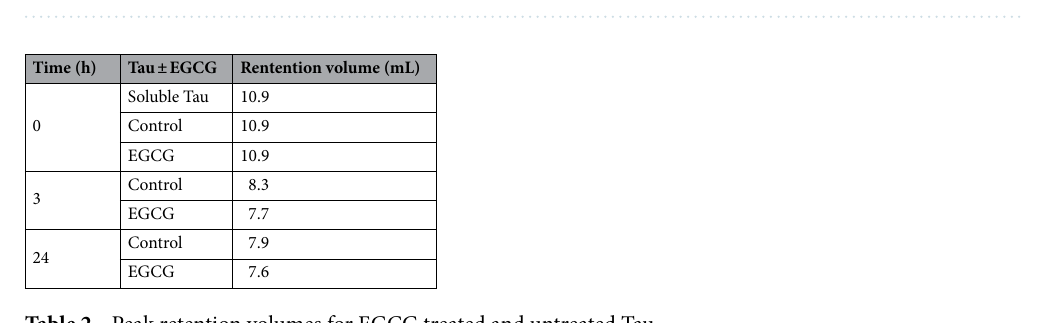
Figure 7. SEC for polyamines treated Tau. Tau was subjected to aggregation in presence of heparin as inducer. ( A ) At 0 h Tau was eluted as monomer, both in presence and absence of EGCG. ( B ) Further incubation led to aggregation of Tau, at 3 h of incubation EGCG showed more aggregation in Tau. ( C ) Similarly, at 24 the peak intensity of Tau in presence of EGCG was high when compared to control. This suggests that EGCG is driving Tau towards the formation of higher order aggregates. ( D ) Cell viability studies indicates that these conformers were non-toxic in neuro2A cells.